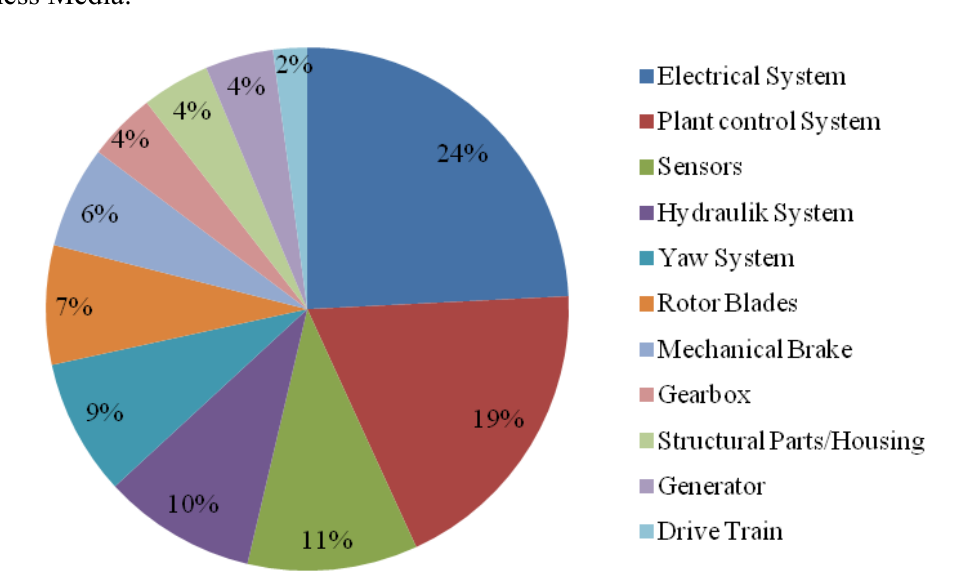
Figure 4. Share of the main components of the total number of failures